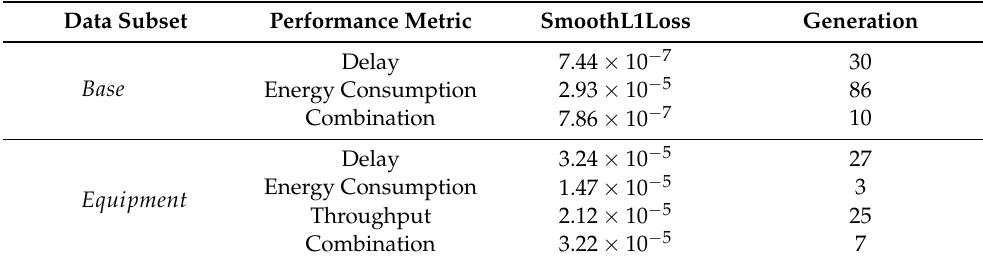
Table 6. Generation convergence of RL with Genetic Algorithm belonging to the highest fitness scored model for single and combined performance metrics suggestion for Dataset Base and Dataset Equipment .